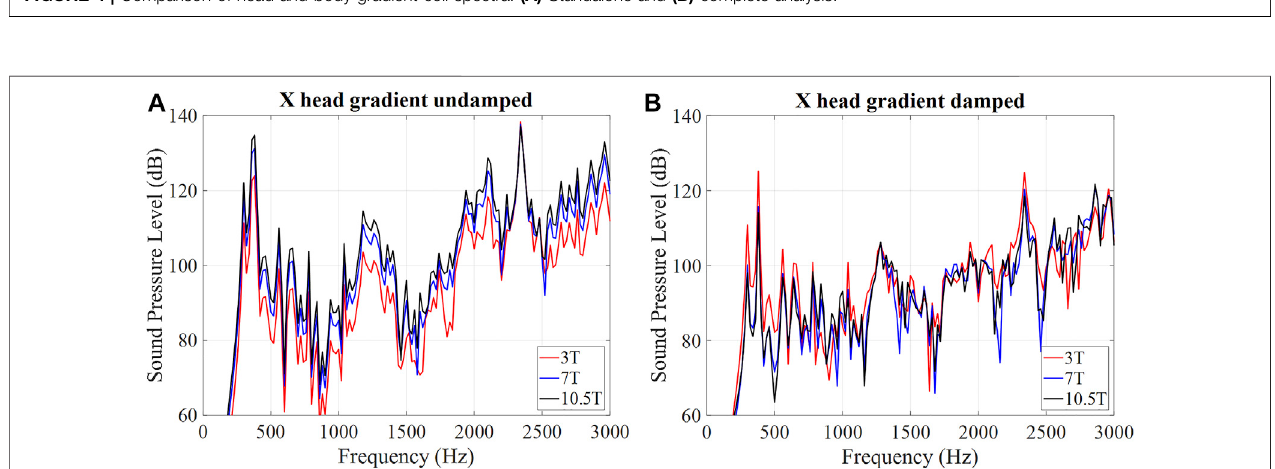
FIGURE 4 | Comparison of head and body gradient coil spectra. (A) Standalone and (B) complete analysis.